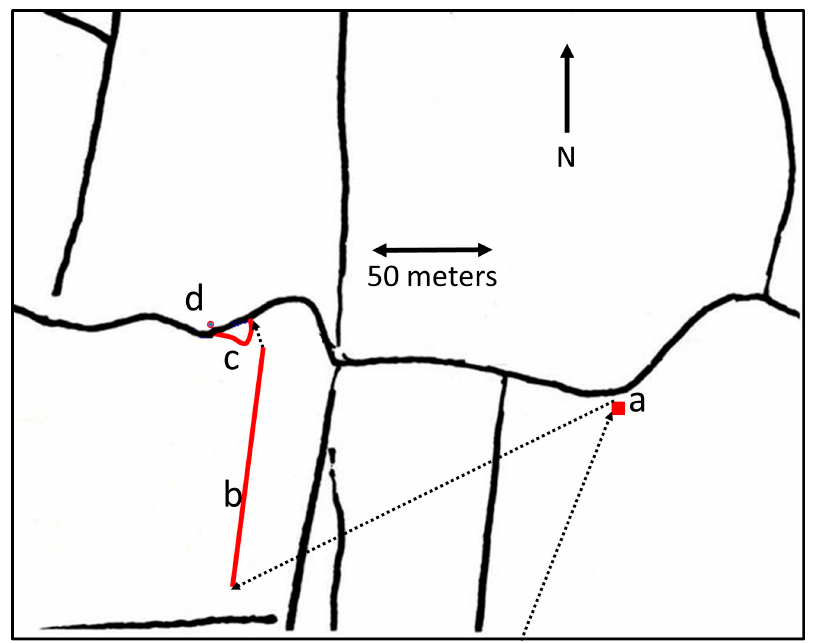
Figure A3. Extract from the 1863 Ordnance Survey map. The locations of the “square hole” (a), the most prominent trench (b), triangular channel (c), and cave (d), and the reported path of the “globe of fire” (dotted line) between features are shown. The field with the “20-foot-square” hole (a) has been drained and is lower than the field with the trench (b) and the triangular channel (c). Therefore, we do not know the relative elevation of the hole (a) and the trench (b) in 1868.